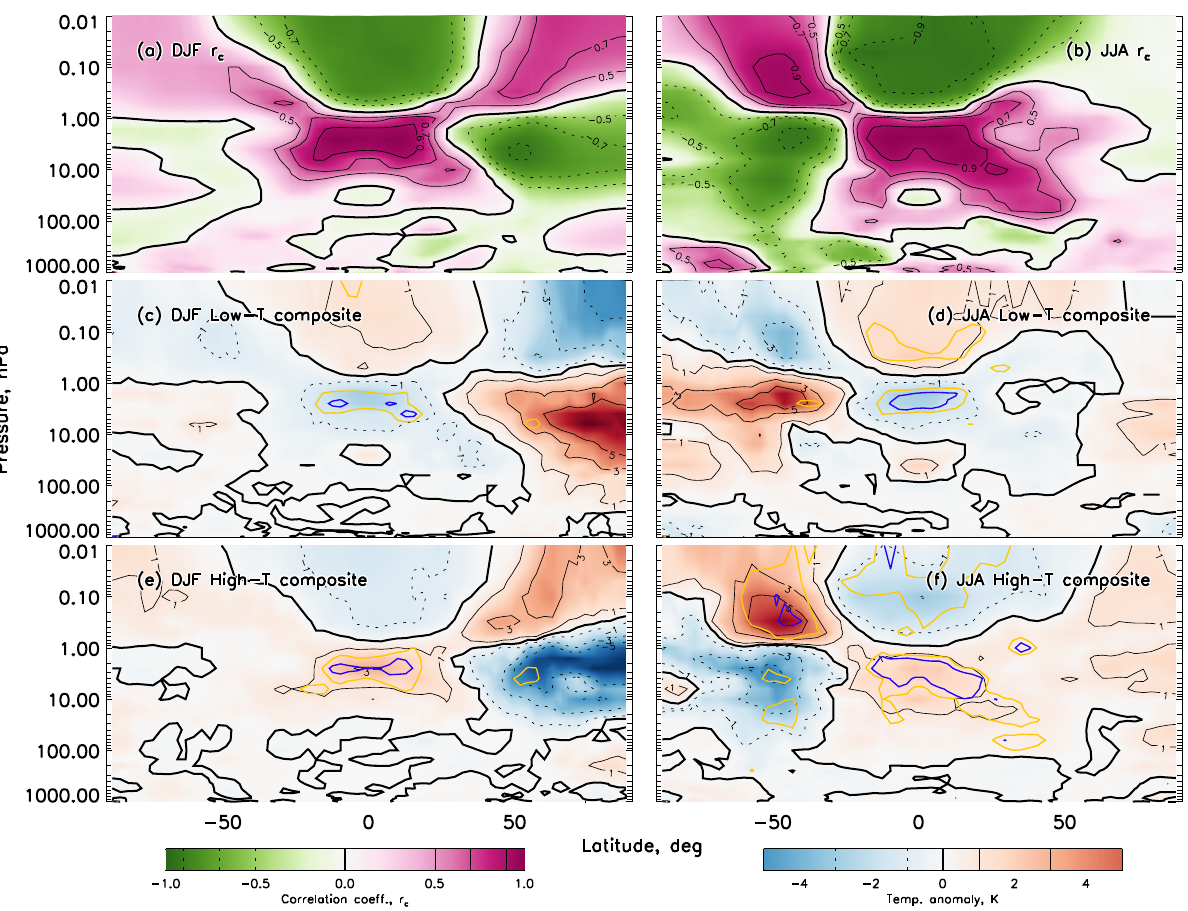
Figure 3. Correlation coefficient maps of zonal-mean 20 ◦ N–20 ◦ S 2.5hPa temperature anomalies from the SOCOL model with respect to latitude and altitude for all identified low- and high- T (a) DJF and (b) JJA events, as defined in Fig. 2. ( c–f ) Composite temperatures for (c) DJF low- T , (d) JJA low- T , (e) DJF high- T , and (f) JJA high- T events. Dashed (solid) contours are negative (positive), with the bold line representing 0. Signals at the 2 and 3 standard deviations from 0 are given as yellow and blue contours, respectively, in (c) – (f) .